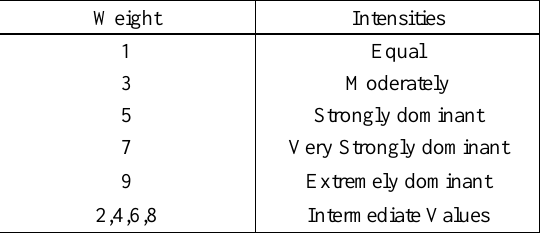
Table1. AHP paired comparison judgments from a fundamental scale of absolute numbers for assigning weight values (Saaty Scale) (Saaty,